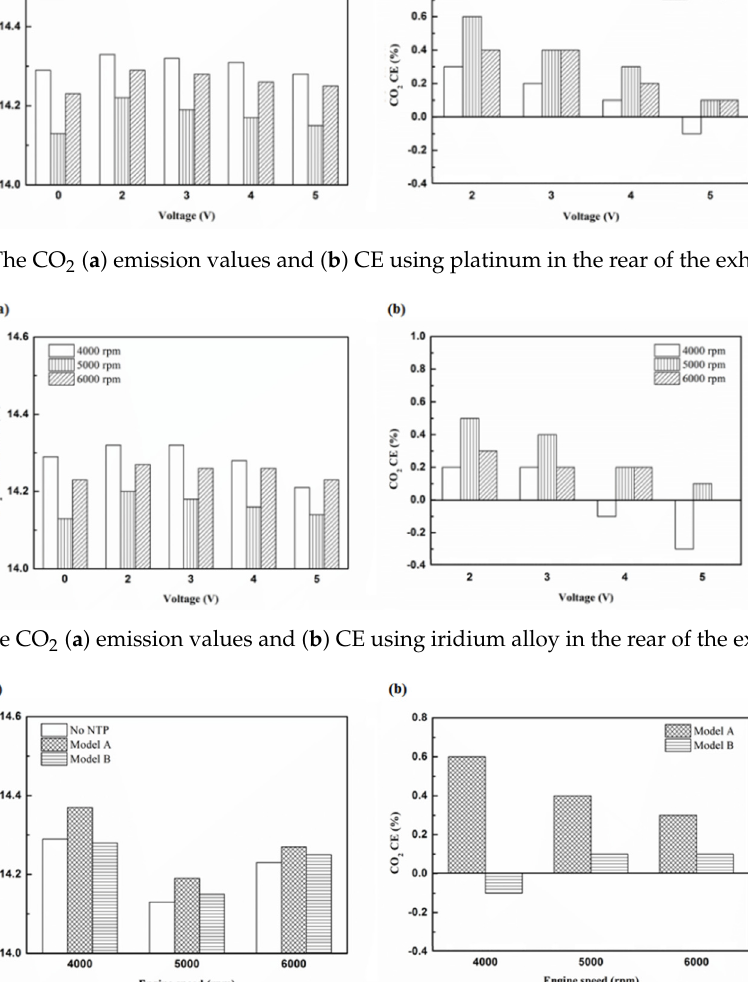
Figure 24. The CO 2 ( a ) emission values and ( b ) CE of control voltage 5 V using platinum.